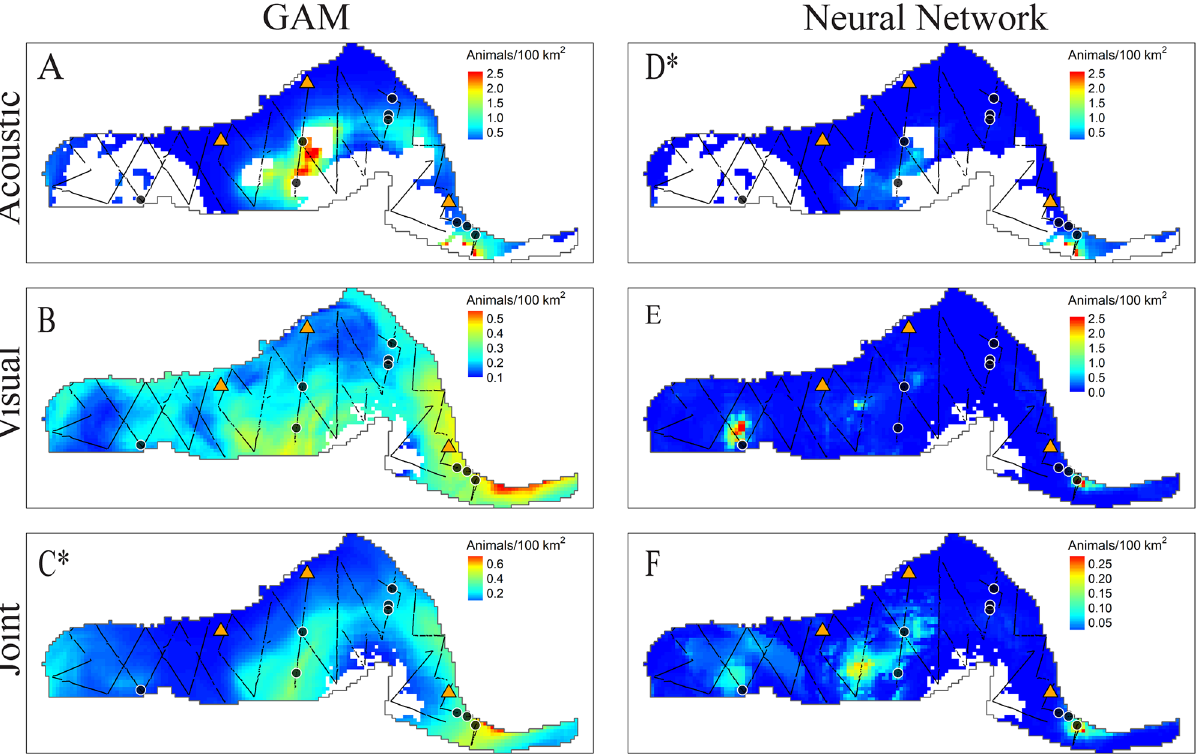
Figure 11. Predicted Risso’s dolphin densities (colormap) across the model area for July 2009 from GAMs ( A – C ), and NNs (subplots D – F ). Subplots from top to bottom represent acoustic-only ( A , D ), visual-only ( B , E ), and joint ( C , F ) model predictions. Note that colorbars vary between visual-only and other models, due to somewhat large differences in the magnitudes of predictions. Annotations as in Fig. 5. Maps created using tmap 45